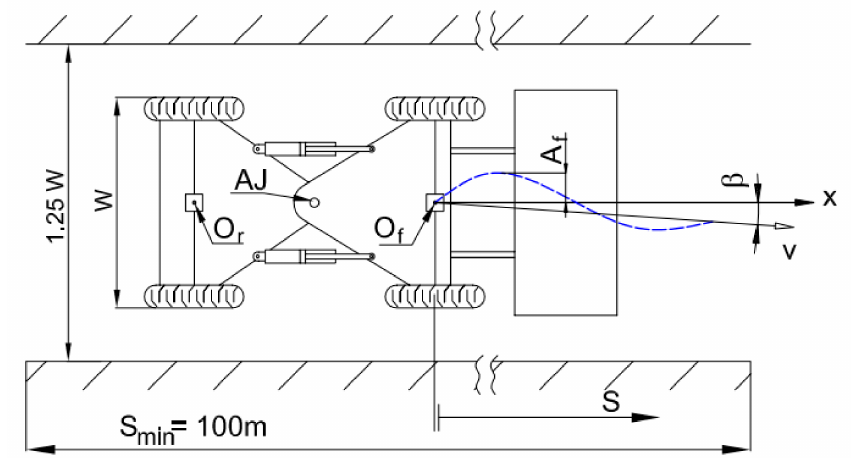
Figure 2. Requirements concerning the steering system of an ASFWV (commercial vehicle), specified in standards